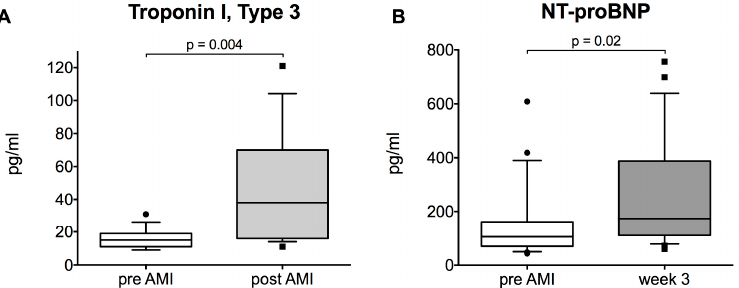
Figure 3. Troponin I, Type 3 pre-acute myocardial infarction (AMI) and 120 min after AMI onset (post-AMI) ( A ) and NT-proBNP before and 3 weeks after AMI ( B ) ( n = 24).